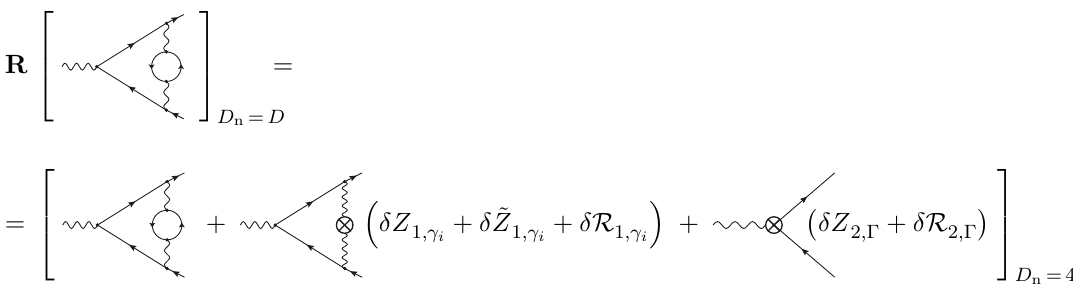
Figure 5 . Graphical representation of the master formula (5.23), see also (1.5), for a globally divergent two-loop QED diagram with a single